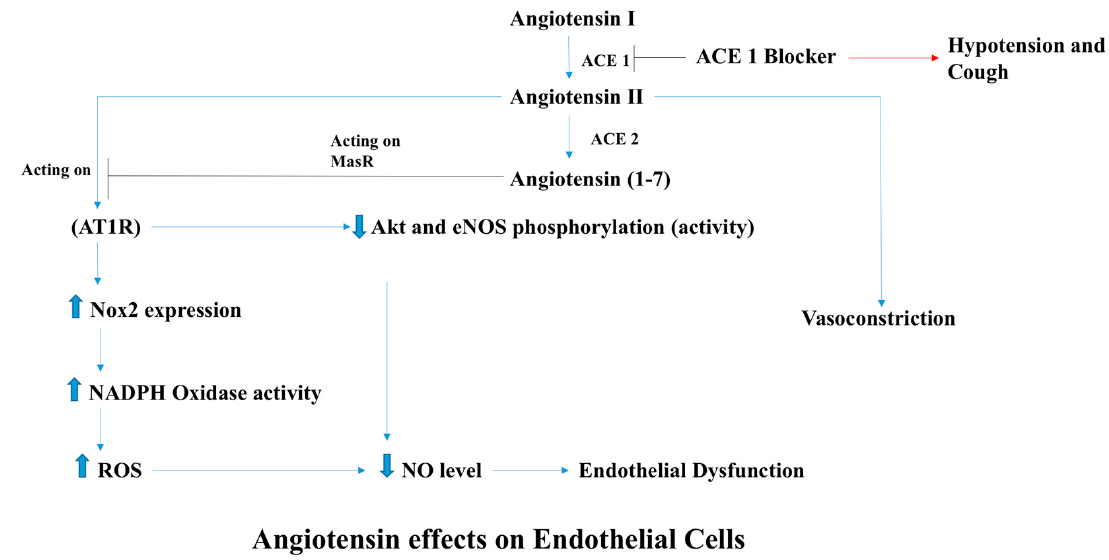
Figure 3. Effects of angiotensin on endothelial cells. AngII induces ROS production in endothelial cell, resulting in vasoconstriction. AngII plays a crucial role in the renin-angiotensin system that maintains blood pressure by inducing sodium and water retention, sympathetic activity, and potent vasoconstriction. Despite the fact that AngII is involved in the regulation of the blood pressure and tissue perfusion, it also exerts pathological effects that have been implicated in cardiovascular diseases, some of which are mediated through the activation of angiotensin type 1 receptor (AT1R). Nox2: NADPH Oxidase-2; ACE 1: Angiotensin Converting Enzyme-1; ACE 2: Angiotensin Converting Enzyme-2.